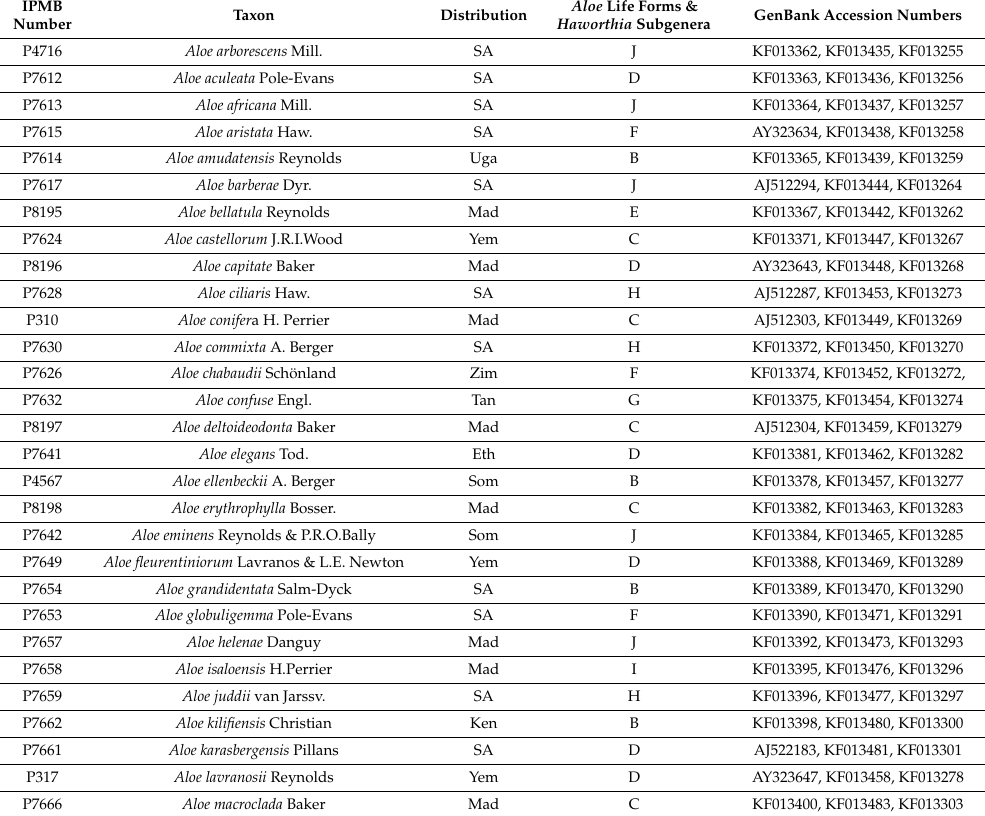
Table 1. Origins of samples. List of specimens, distribution of plant samples, morphological information, number in the herbarium of the Institute of Pharmacy and Molecular Biotechnology (IPMB) and GenBank accession numbers (from our own sequence analyses) listed in this order: rbc L, trnL_F and ITS. Aloe life forms are according to Carter et al. (2011) [27]: A = grass aloes, B = maculate aloes, C = stemless aloes (in small clumps, flower stems few-branched), D = stemless aloes (in small clumps, flower stems multi-branched), E = stemless aloes (in large clumps, flower stems few-branched), F = stemless aloes (in large clumps, flower stems multi-branched), G = pendulous or sprawling aloes, H = shrubby aloes (flower stems few-branched), I = shrubby aloes (flower stems multi-branched), J = tree aloes. Subgeneric classification of Haworthia is based on Bayer (1999) [17]: HA = subgenus Haworthia , HE = subgenus Hexangulares and RO = subgenus Robustipendunculares . Distribution abbreviations: SA = South Africa, Uga = Uganda, Mad = Madagascar, Mal = Malawi, Ken = Kenya, Yem = Yemen, Moz = Mozambique, Zim = Zimbabwe, Tan = Tanzania, Sud = Sudan, Eth = Ethiopia, Som = Somalia, Zam = Zambia, Bot = Botswana, Ang = Angola, Zan = Zanzibar, Swa = Swaziland, Eri = Eritrea, Nam = Namibia, Oma =